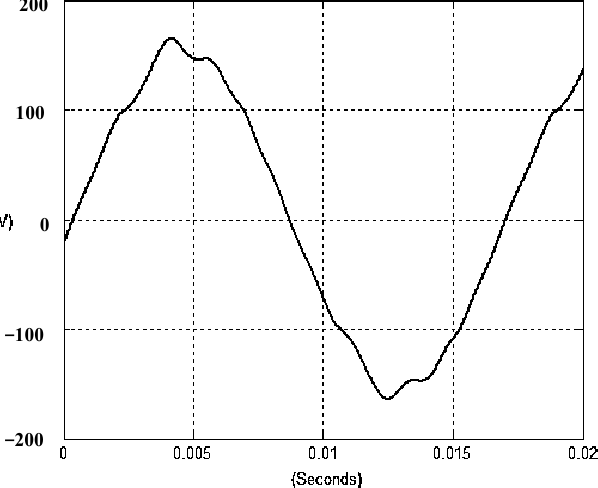
Figure 9. Simulated AC output voltage for the traditional SMRL under rectifier load.